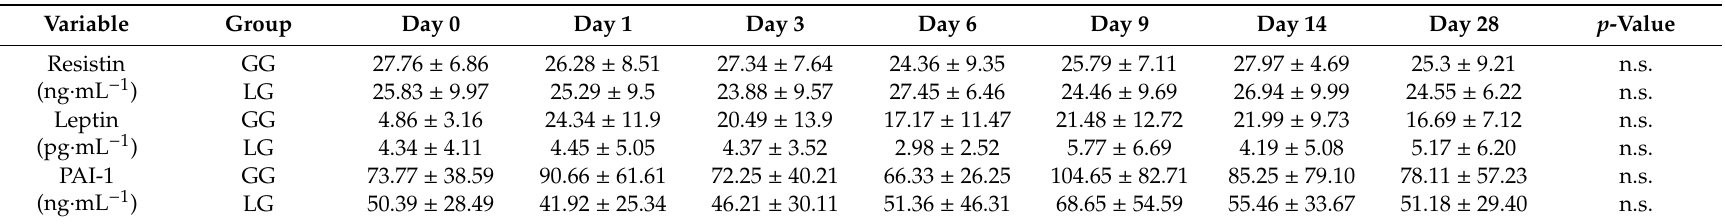
Table 5. Plasma concentrations of selected hormones of adipose tissue in the subset of diabetic patients (mean values with standard